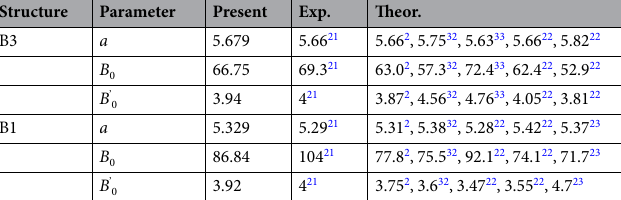
Structure Parameter Present Exp. Theor.